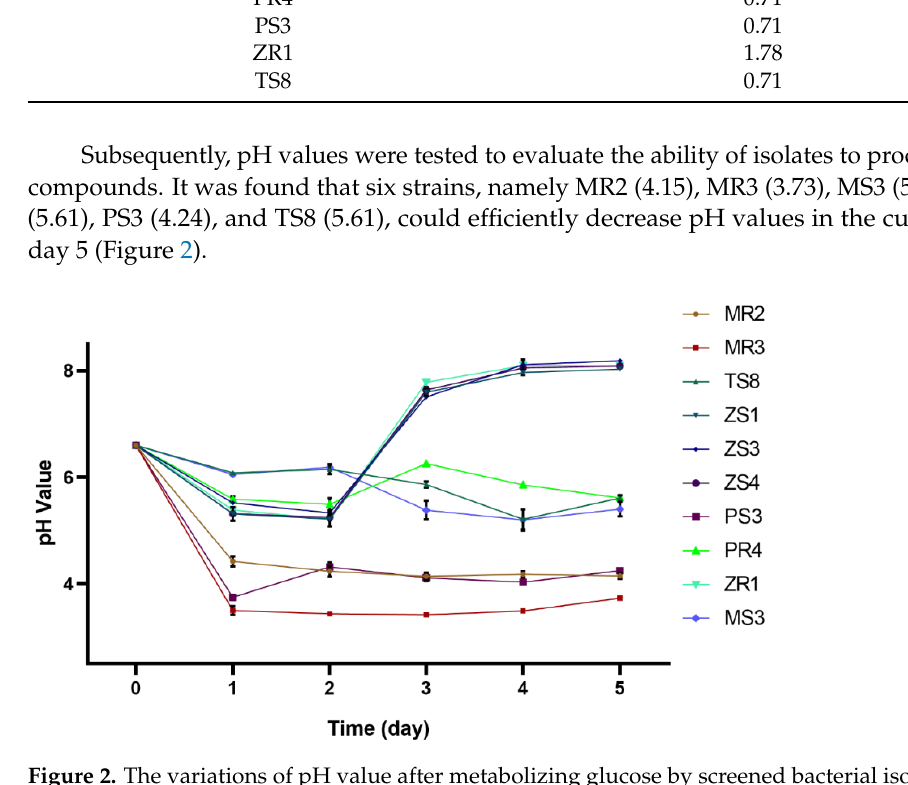
Table 2. Cadmium maximum tolerance concentration of screened bacteria.